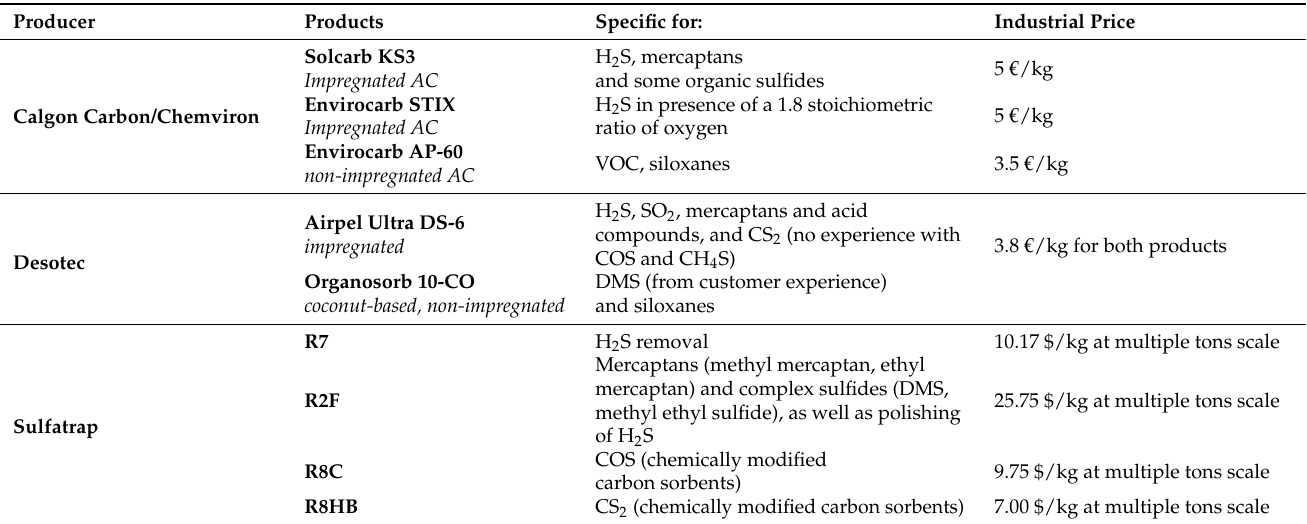
Table 5. List of several commercial sorbents and their industrial cost. Based on the market survey performed in the framework of the EU Project Waste2Watts, 2020